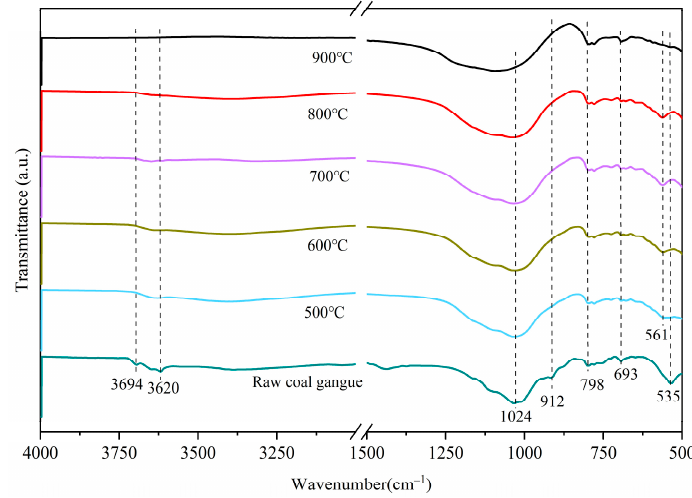
Figure 8. FTIR spectra of the CG sample calcined at different activation temperatures.